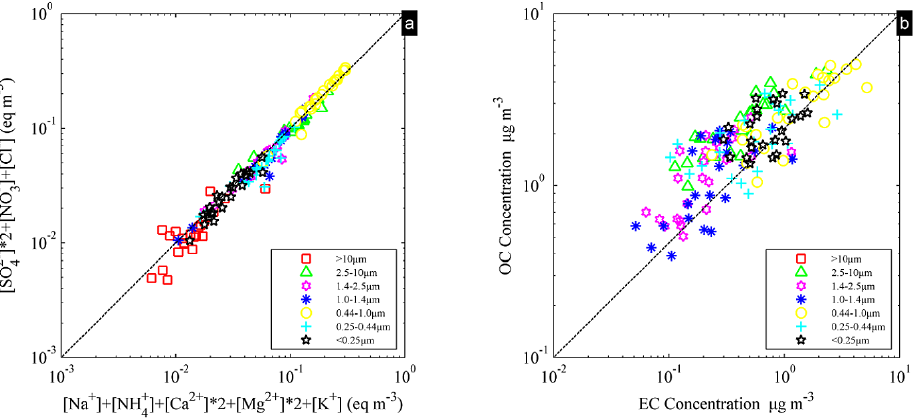
Figure 1. Measurement data collected during May, June, November and December in 2010. (a) The balance of charge equivalence between cations and anions. (b) Mass concentrations of EC versus